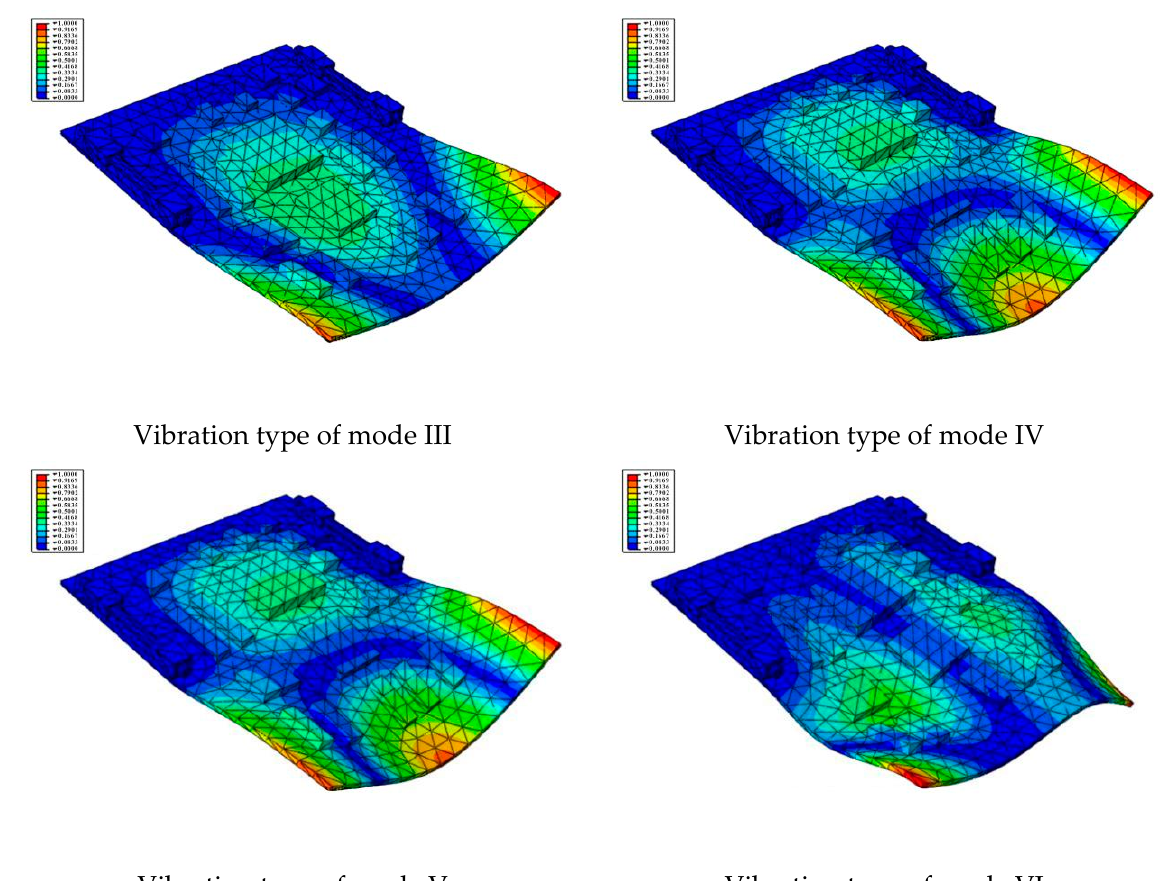
Figure 2. The first 6 modes vibration type based on stress of CPU finite element model.